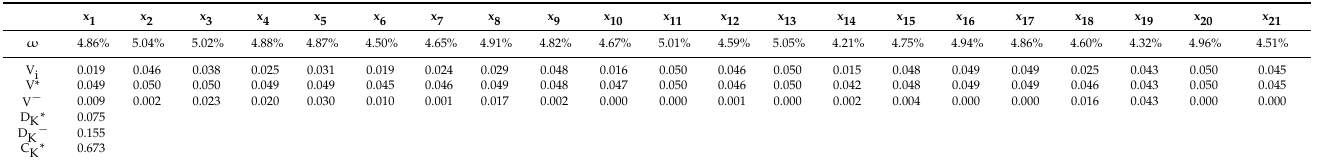
Table 9. The TOPSIS data of Guangdong